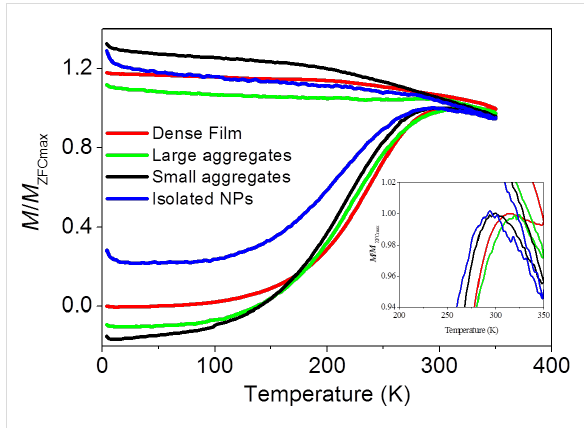
Figure 11: Thermal variation of the normalized dc magnetic magneti- zation measured in zero-field cooling (ZFC) conditions for the assem- bled PMMA-decorated ENP sample series (see Figure 10). Details around the maximum of the magnetization is given in the